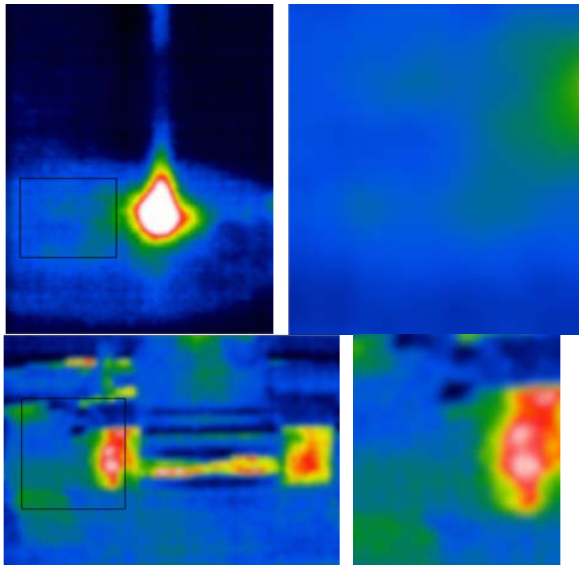
Fig. 5. The example IR images The result of processing IR images proposed of the multicriteria method smoothing (Fig. 5) is presented in Fig. 6. The images have been reduced. Areas with a temperature gradient and the name of the device were cut. Figure 6 shows a smoothed image and an enlarged area highlighted by a square.